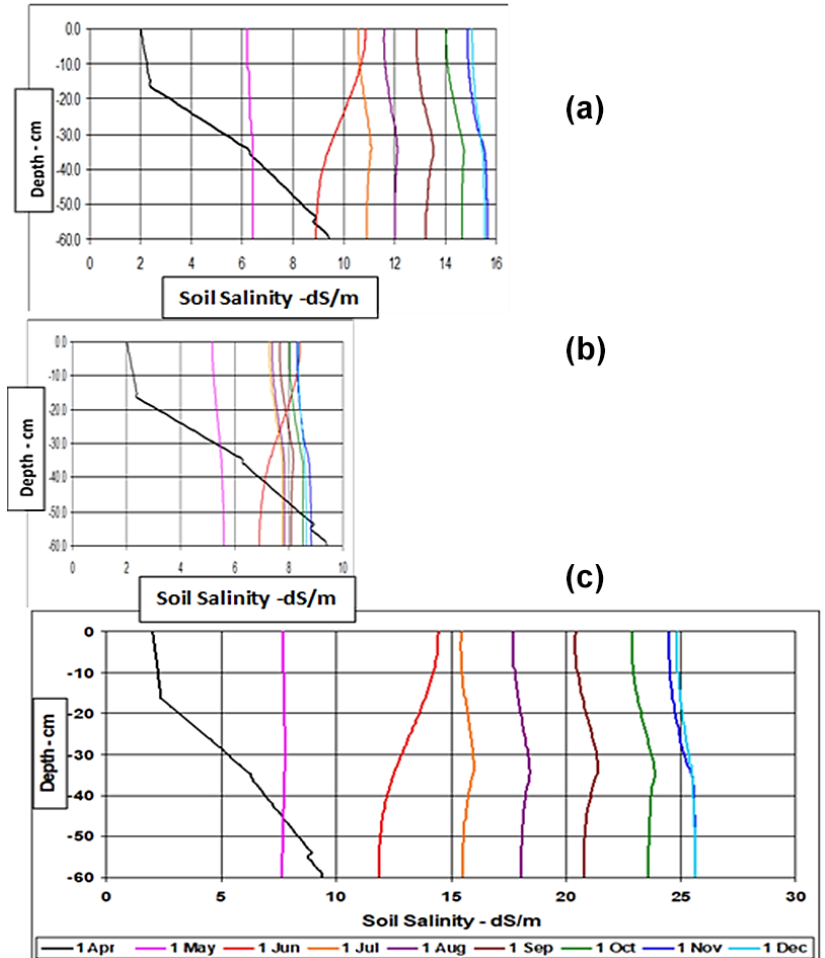
Figure 16. Salt accumulation predictions in the soil during the irrigation season under different water salinity: (a) 3.13dSm − 1 (available today); (b) 1.5dSm − 1 (potable water); (c) 5.5dSm − 1 (brackish